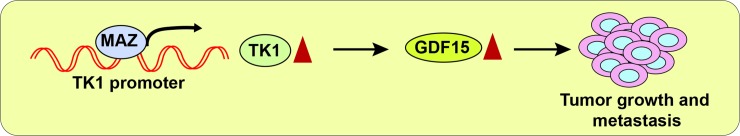
Model showing the mechanism by which TK1 facilitates LUAD tumor growth and metastasis.We find that TK1 promotes the expression of GDF15, which acts downstream of TK1 to mediate its ability to promote tumor growth and metastatic attributes in LUAD cells.